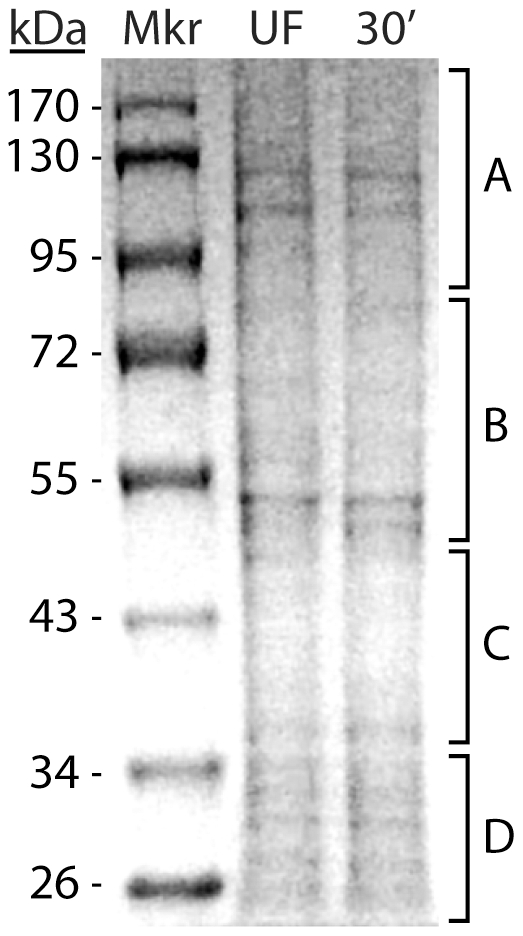
Isolation of microsomal proteins for LC-MS/MS analysis from unfed and amino acid fed Ae. aegypti mosquitoes.Three-day-old female mosquitoes were unfed or amino acid fed and dissected after 30 min. Microsomal protein samples were prepared as described in Materials and Methods and resolved on a 12% SDS-PAGE gel. Following protein staining, four equal slices of polyacrylamide gel were prepared from each lane (A, B, C, or D) and proteins were subjected to in-gel trypsin digestion prior to LC-MS/MS analysis. Note that minimal differences exist in the quality and quantity of abundant proteins in the two protein samples, suggesting that the 30 min. time point is prior to the onset of feeding-induced protein synthesis.